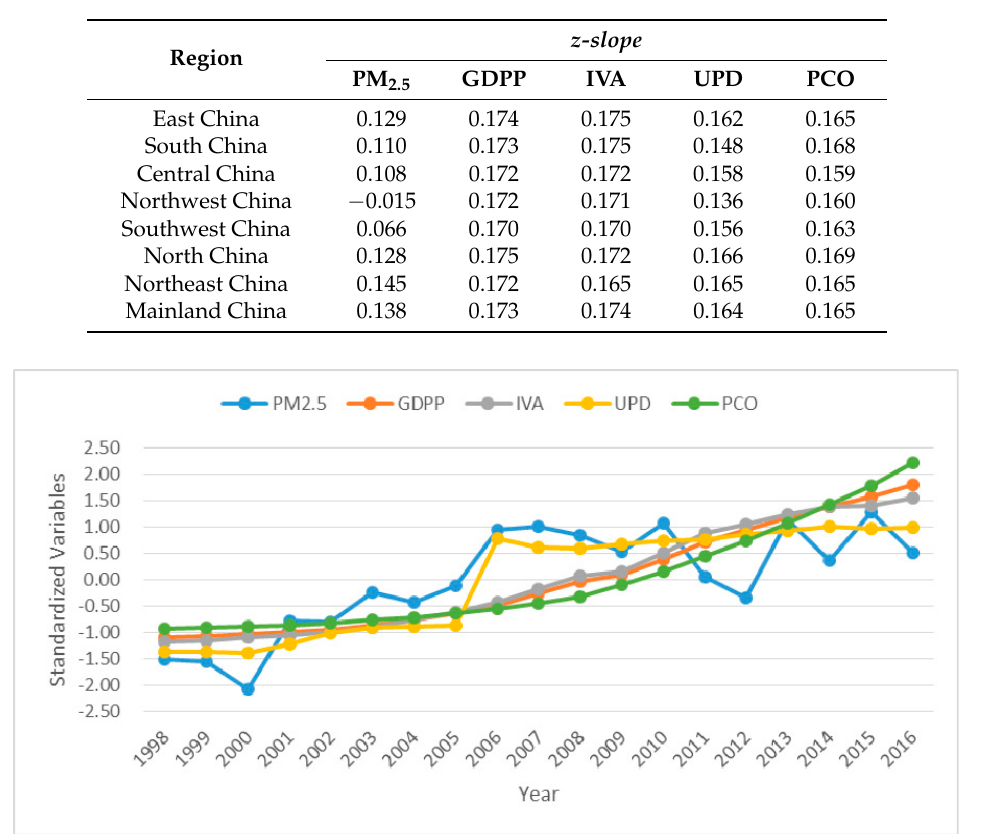
Table 2. The variation trend of PM 2.5 , GDPP, IVA, UPD and PCO in the seven geographical subareas and Mainland China, 1998–2016.